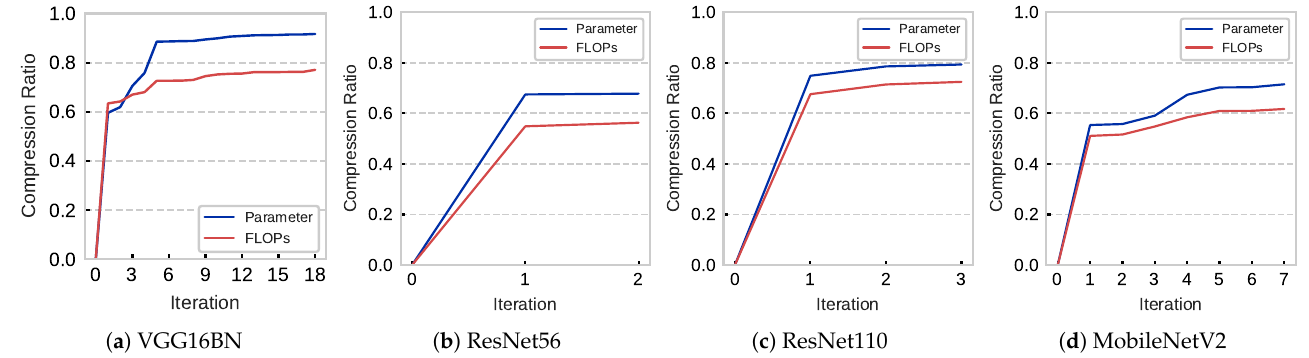
Figure 5. The graphs show the compression ratio for FLOPs and the parameters of pruned models after each iteration in the experiments on Cifar10 with 1% ACC D